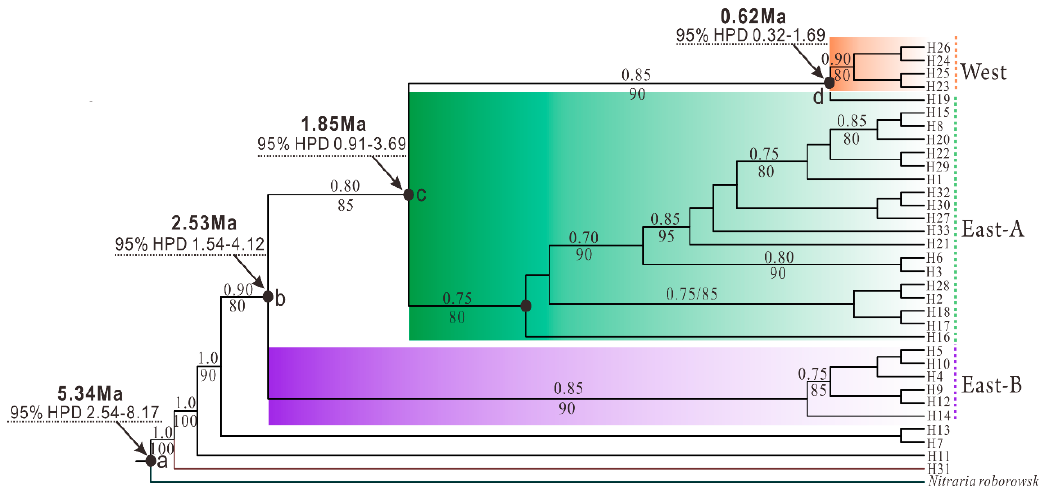
Figure 4. Phylogenetic relationship between Nitraria tangutorum haplotypes based on the concatenated dataset of five chloroplast DNA (cpDNA) fragments. Nodes indicate mean age estimates and 95% confidence intervals. Numbers above the tree branches indicate the bootstrap values calculated using posterior probabilities using BEAST software, while numbers below the tree branches represent maximum likelihood calculated using PhyML software. The black solid circles with the points “a” to “d” indicate divergence time between two clades. HPD, 95% highest posterior density.